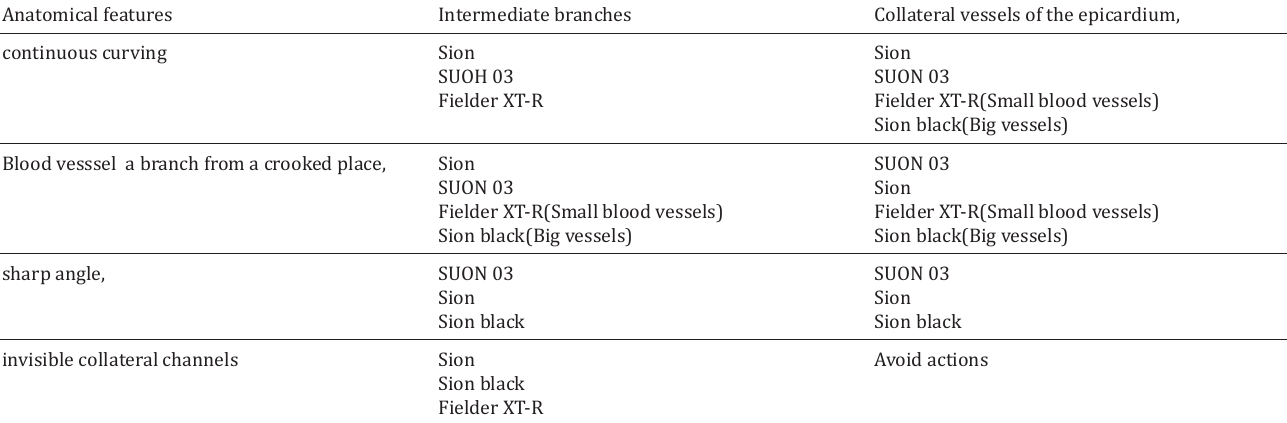
Table 2 Frequently used guide wire by CTO-PCI